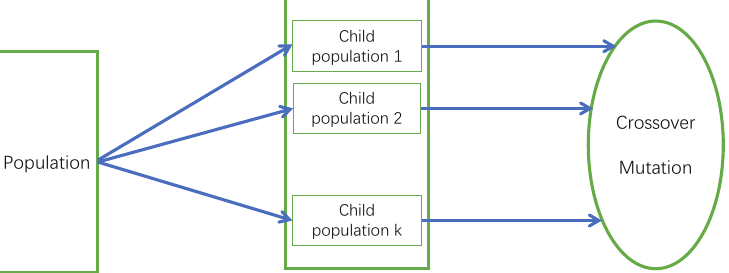
Figure 3. The operation mechanism of VEGA. The MOP is divided into groups, each sub-objective function is evaluated and selected independently, then a new group is formed, crossover and variation operations are performed, and this proceeds cyclically, resulting in non-inferior solutions to the problem. This figure is adopted from